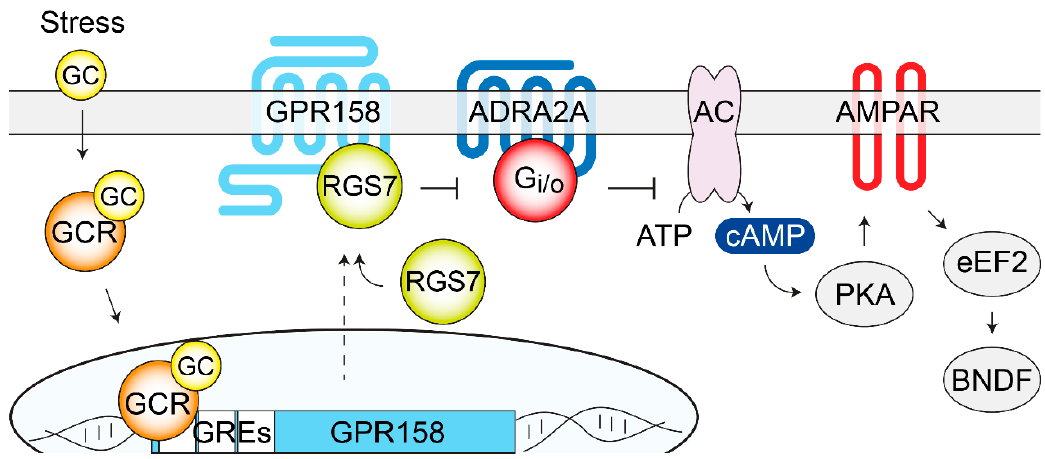
Figure 4. GPR158 / RGS7 complex is a stress-induced modulator of depressive behaviors. GC released by stress bind to intracellular GCR in the mPFC and trigger GPR158 transcription. Increased amounts of GPR158 at the plasma membrane recruit additional RGS7 that regulates many canonical GPCRs (ADRA2A and GABABR have been described). Downstream signaling cascades, modulated by the GPR158 / RGS7 complex, include cAMP-PKA, phosphorylation and expression levels of glutamate AMPA receptors, phosphorylation of eEF2, and BDNF local synthesis. Overall, these cellular adaptations are likely responsible for mood regulation. AC, adenylate cyclase; ADRA2A; α 2-adrenergic receptor; AMPAR, α -amino-3-hydroxy-5-methyl-4-isoxazolepropionic acid; BDNF, brain derived neurotrophic factor; eEF2, eukaryotic elongation factor 2; GC, glucocorticoids; GCR, glucocorticoid receptor; GRE, glucocorticoid response elements; PKA, protein kinase A; RGS7, regulator of G protein signaling 7.